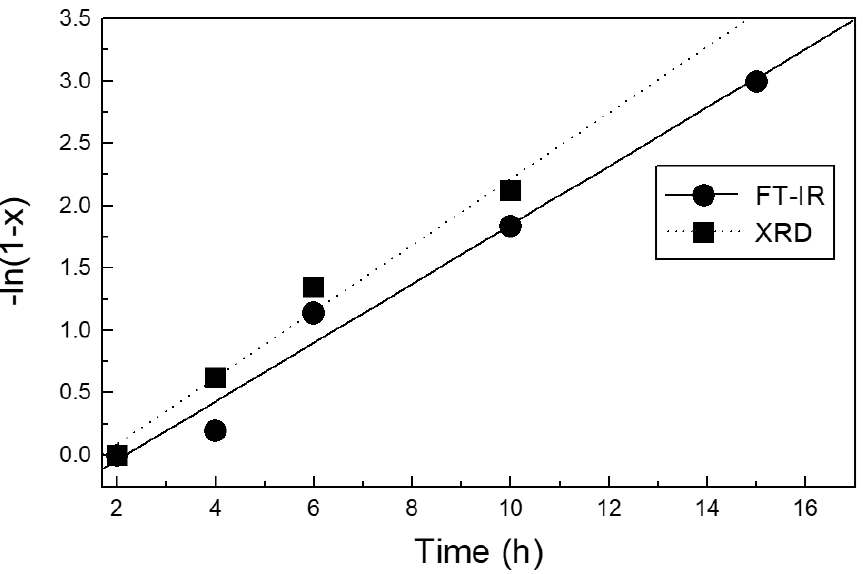
Figure 7. Plots of [ − ln(1 − x) ] versus the time of crystallization for AlPO 4 -11, obtained from XRD and FT-IR data. The dotted and solid lines denote linear fits.